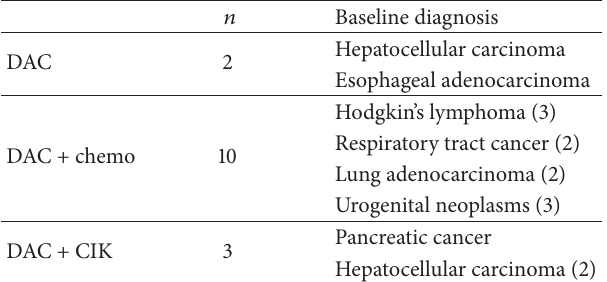
Hepatocellular carcinoma